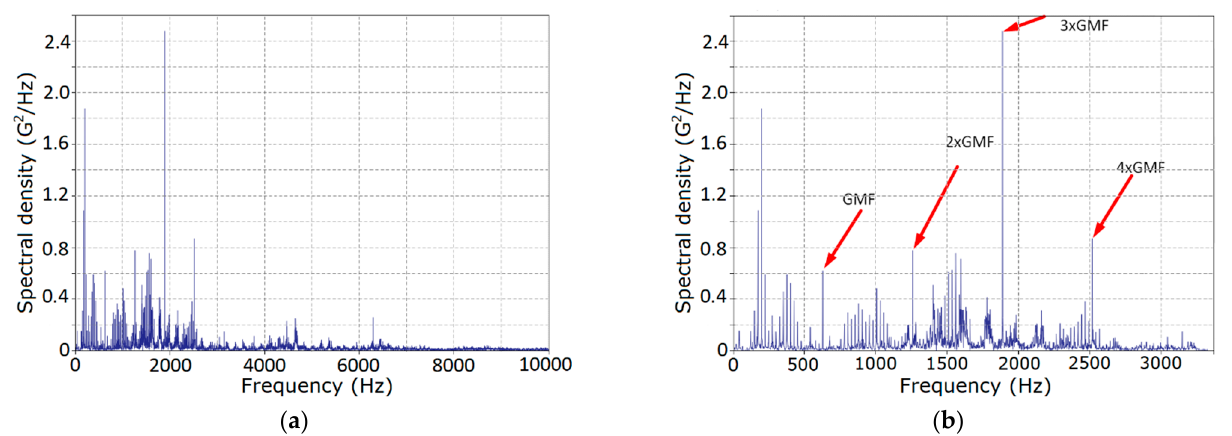
Figure 3. The estimators of the power spectral densities of the stationary approximation for the raw signal: ( a ) original and ( b ) zoomed.